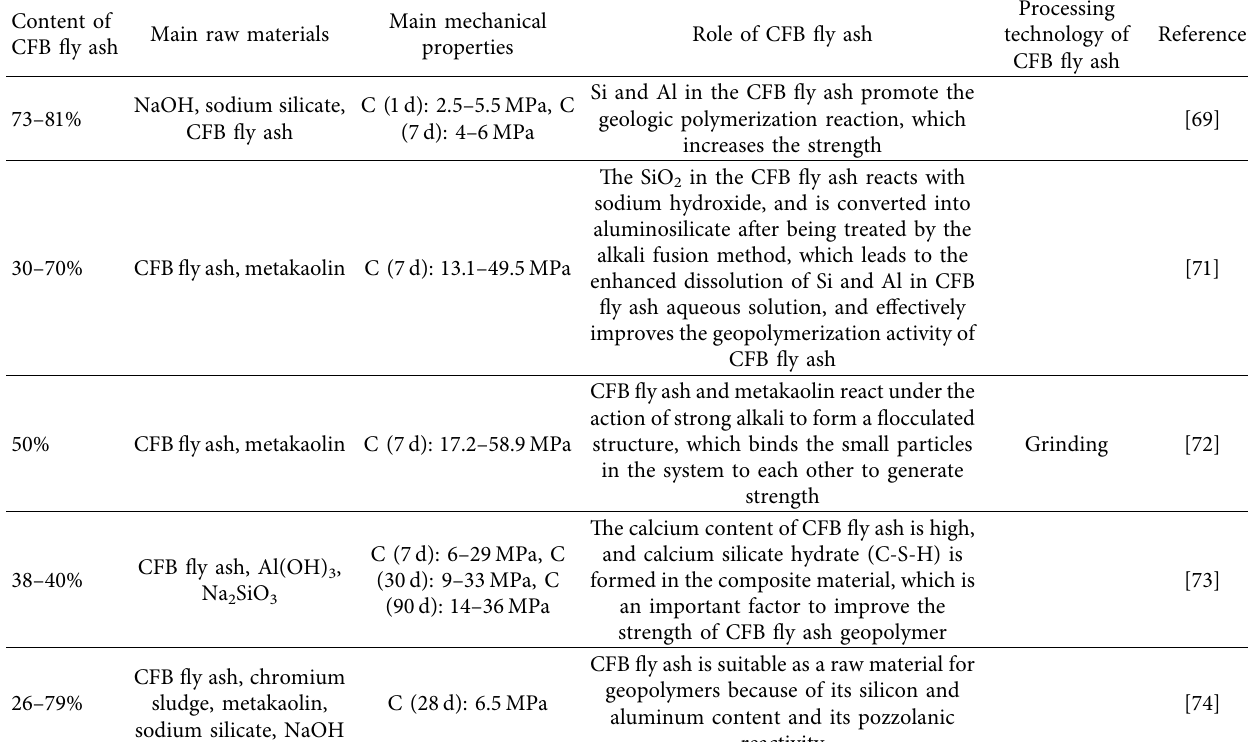
Table 7: Application of CFB fy ash in